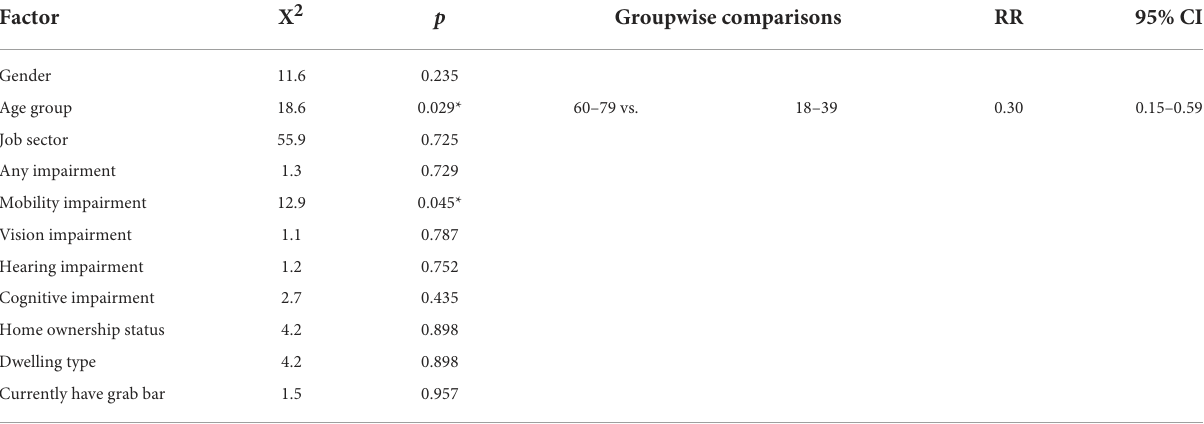
TABLE 5 Probability of objecting to mandatory grab bar installation (GB3): Comparison by respondent demographic characteristics, disability status and living environment.